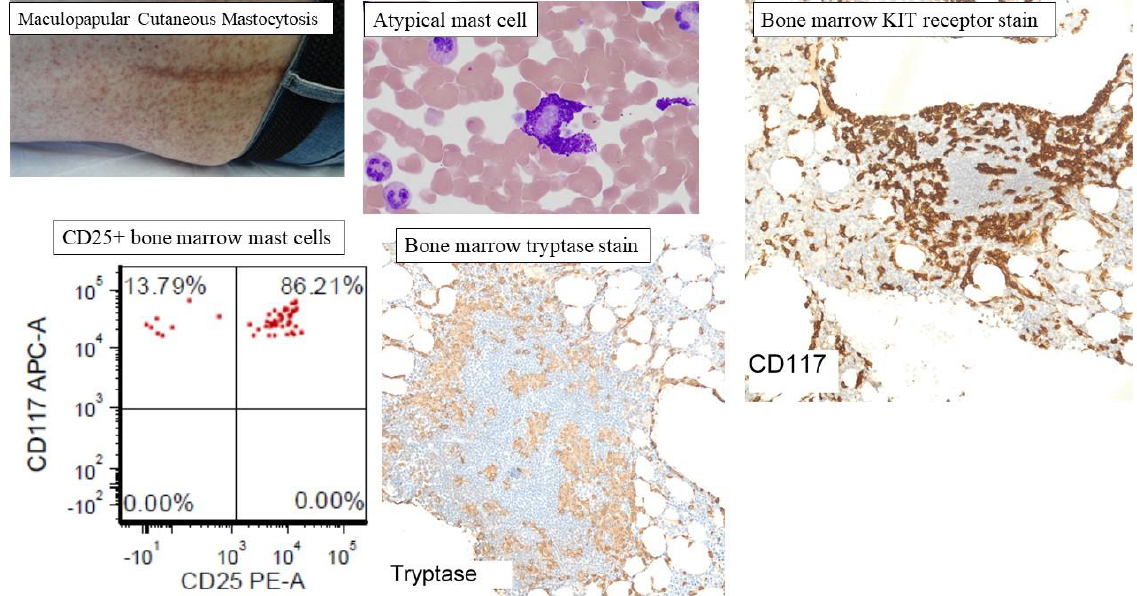
Figure 3. Representative clinicopathological features of mastocytosis. Cutaneous mastocytosis is subcategorized as maculopapular cutaneous mastocytosis (MPCM), also known as urticaria pigmentosa or diffuse cutaneous mastocytosis (DCM), and mastocytoma of the skin. MPCM is the most common presentation of CM with hyperpigmented nodules, papules, or macules distributed randomly, and appearing most commonly on the trunk. The figure shows representative atypical mast cells, mast cell aggregates in the bone marrow (CD117 and tryptase staining), and CD25+ atypical mast cells on flow cytometry of bone marrow aspirate.